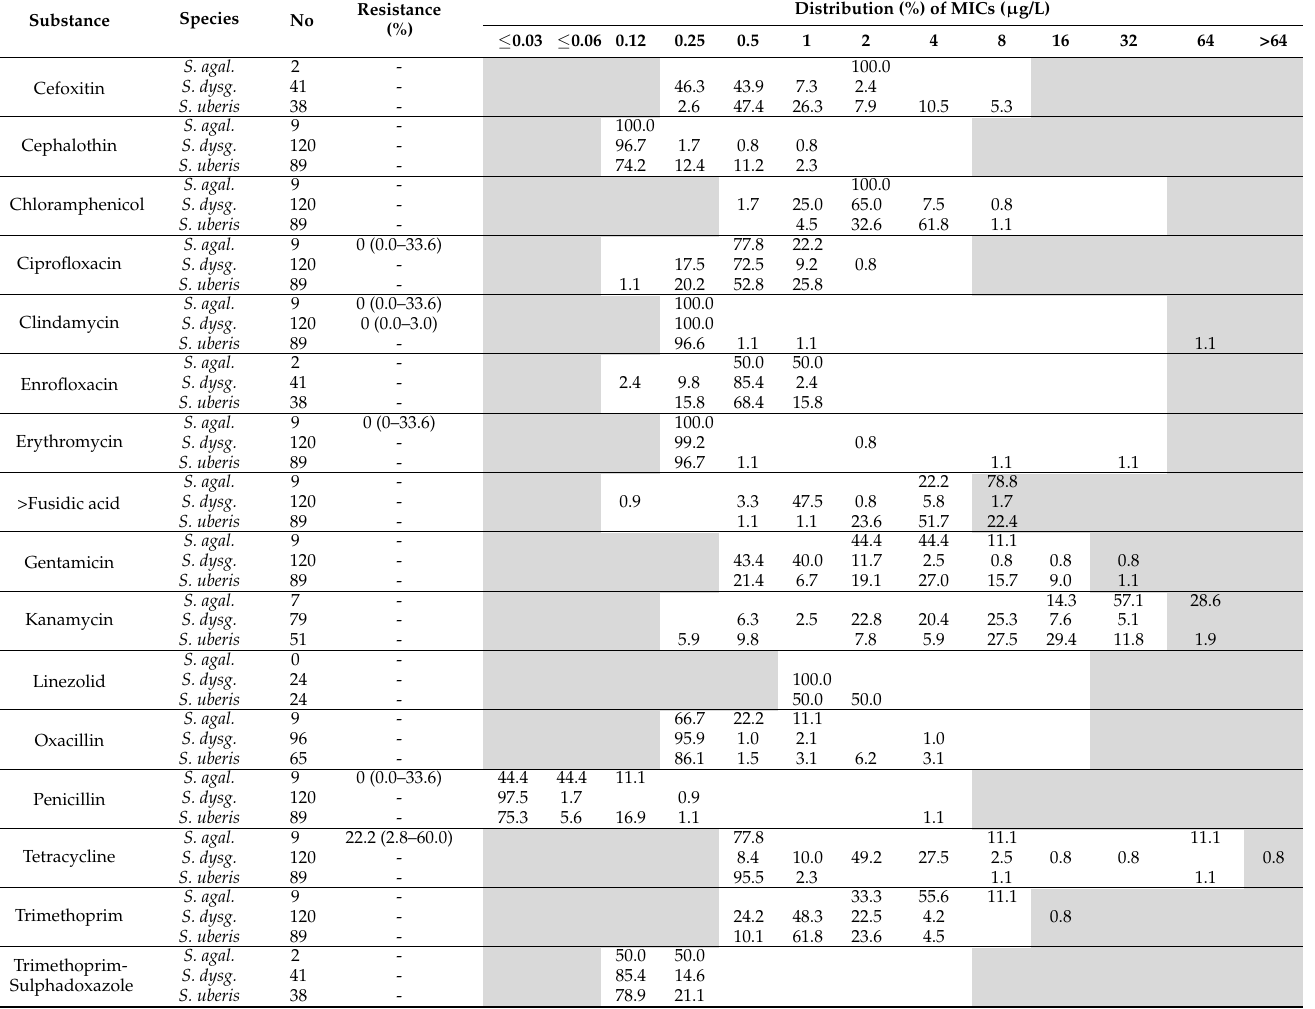
Table 3. Number of tested isolates (No), resistance (per cent, 95% CI in brackets), and MIC distribution (%) for Streptococcus agalactiae , Streptococcus dysgalactiae and Streptococcus uberis from clinical mastitis in dairy cows. White fields indicate test range for each